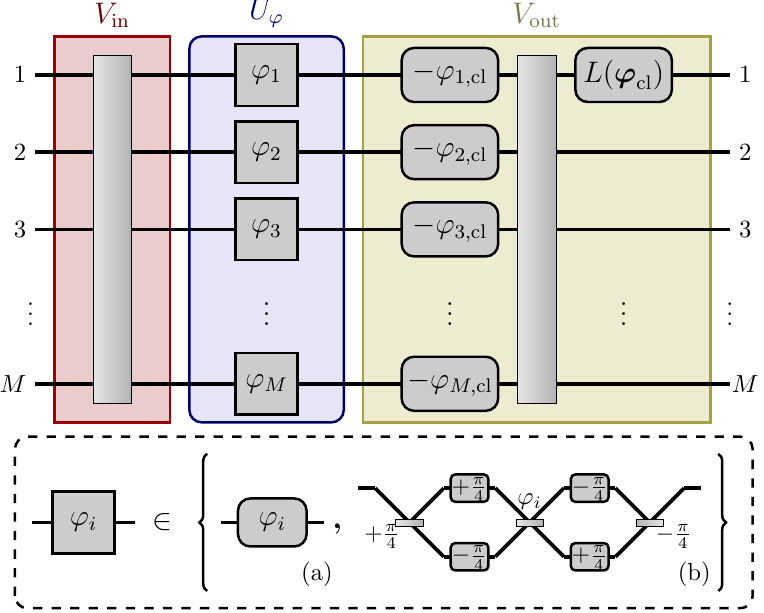
Figure 5. Network for the estimation at the Heisenberg limit of any linear combination of M parameters with positive weights, as shown in Equation (55) [37]. As shown in the lower panel, each parameter ϕ i can either be (a) an optical phase acquired through a single-mode phase-shift, or (b) the reflectivity of a lossless beam-splitter. The network (b) is given in Equation (56), and its purpose is to transform the reflectivity into an optical phase. Two auxiliary stages ˆ V in and ˆ V out are employed, whose purpose is to distribute the probe according to the weights in the linear combination (see Equation (59)), and to refocus the probe into the first output port of the network (see Equation